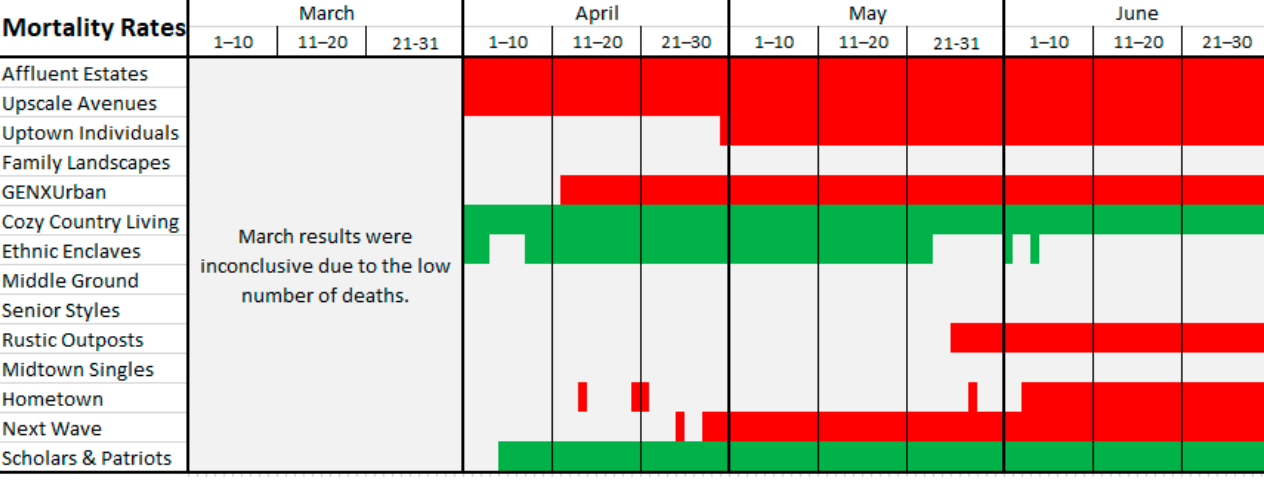
Figure 4. COVID-19 mortality risk by LifeMode and date. Red color indicates high risk for that LifeMode and date; green color indicates low risk for that LifeMode and date; white color indicates inconclusive risk.